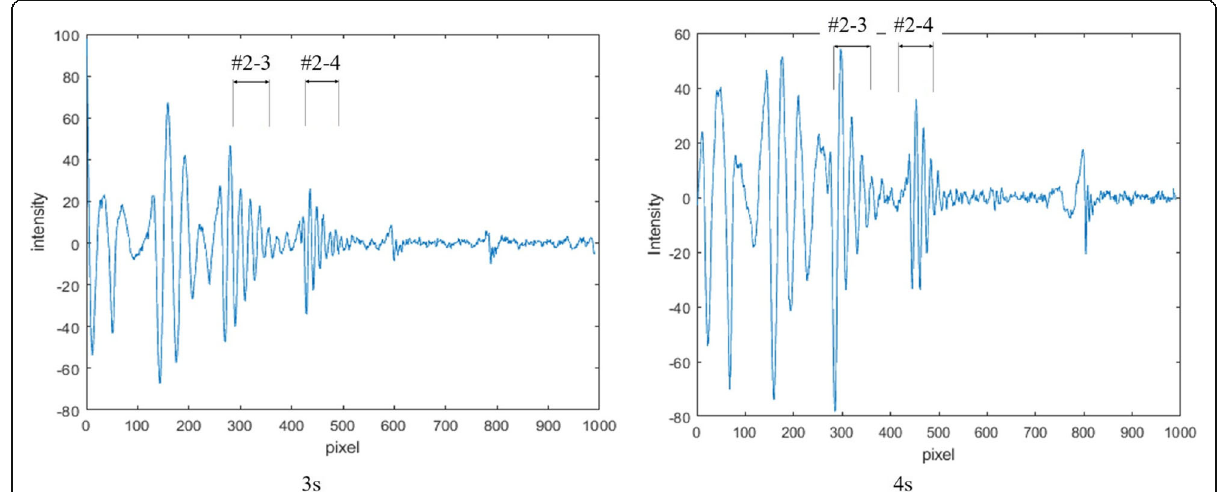
Fig. 11 Total intensity distribution at t = 3 s and 4 s for downstream of cylindrical roughness